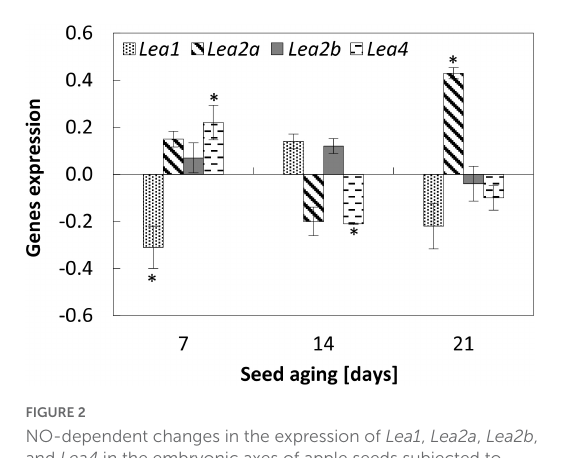
FIGURE2 NO-dependent changes in the expression of Lea1 , Lea2a , Lea2b , and Lea4 in the embryonic axes of apple seeds subjected to accelerated aging for 7, 14, and 21 days. Values are average ± SD of 3 repetitions. Asterisks indicate significant differences between the treated sample compared to the control sample, obtained by the Student’s t- test ( P <